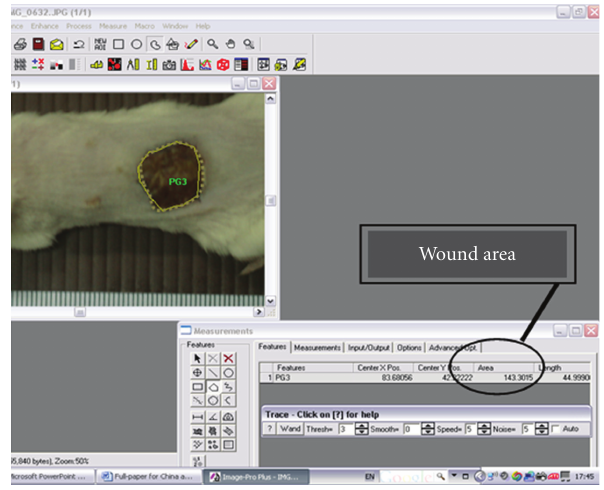
Figure 1: Wound area (mm 2 ) of each mouse was determined by using Image Pro II 6.1 software.